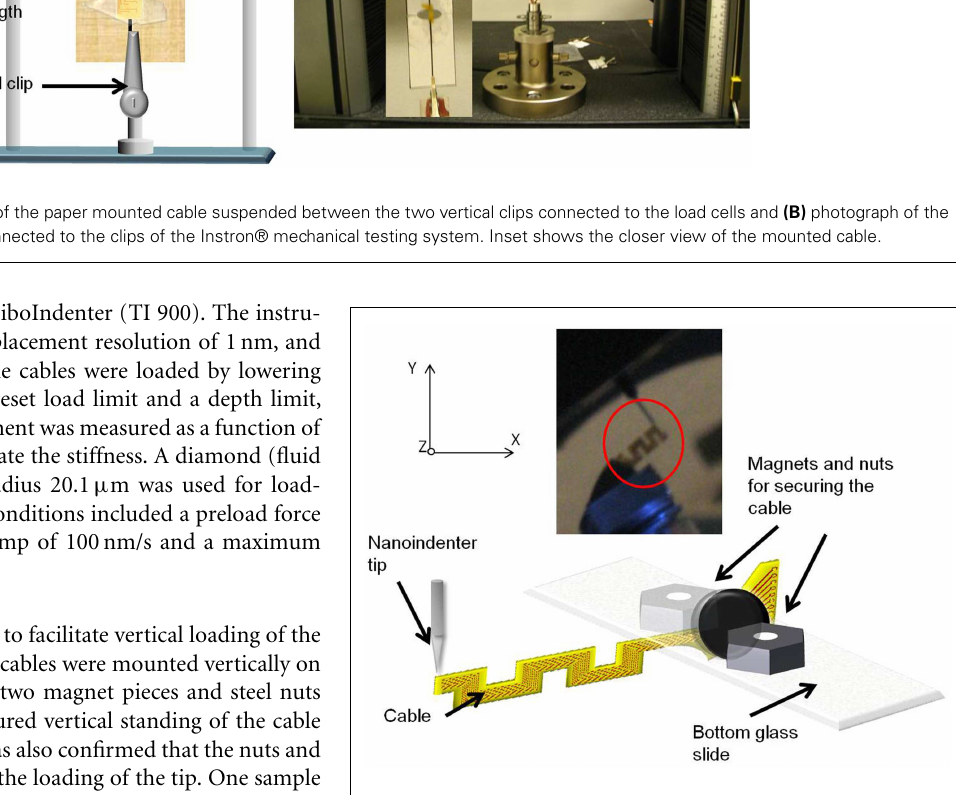
FIGURE 7 | Schematic diagram showing the vertical loading of the serpentine cable in y -axis by the nanoindenter tip . Inset showing the photograph of the cable and the nanoindenter